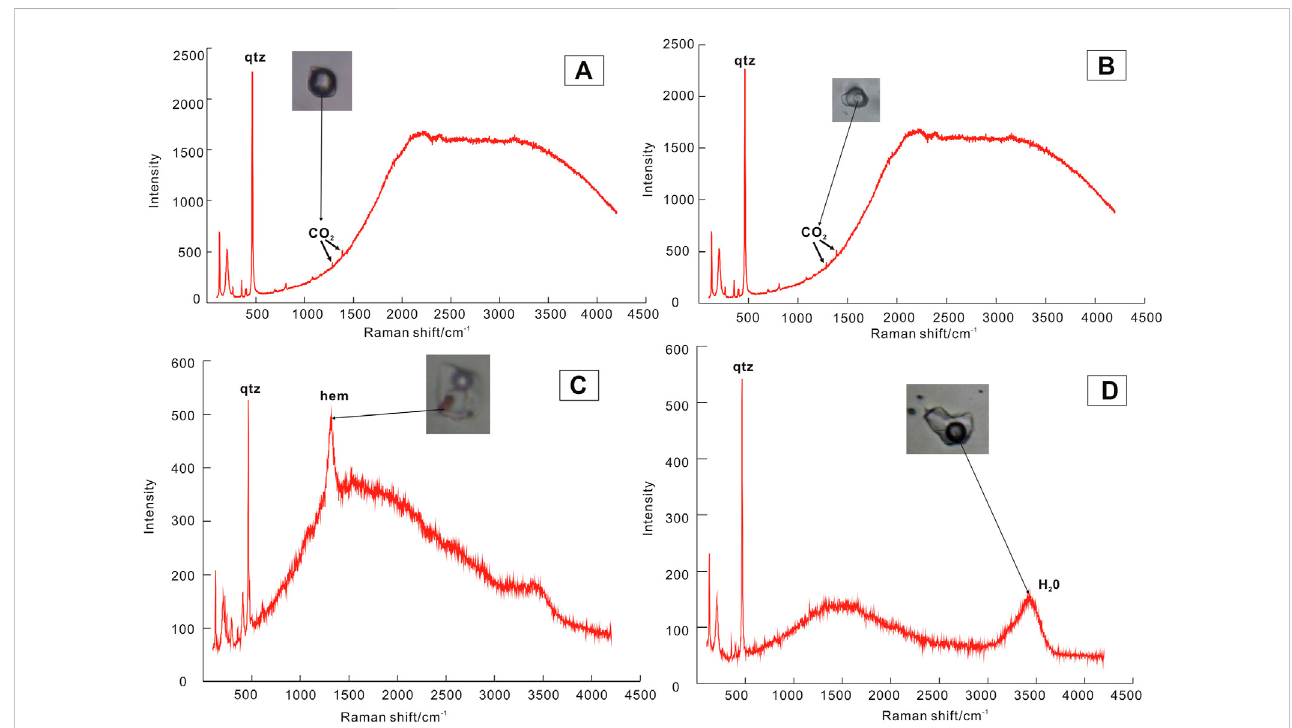
FIGURE 8 LaserRamanspectraof fl uidinclusions. (A,B) CO 2 invaporphaseofV-typeinclusion. (C) hematitedaughtermineralinS-typeinclusion. (D) H 2 Oinvapor phase of L-type inclusion. Abbreviations: hem-hematite, qtz-quartz.